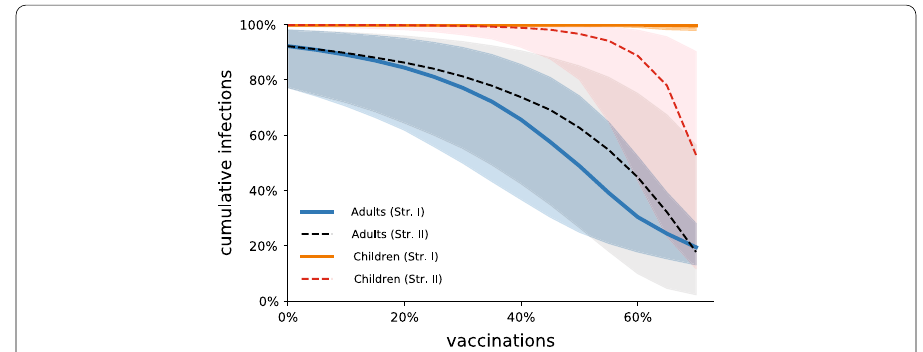
Fig. 11 Scenario of the Delta variant. We show the Monte Carlo estimation (over 100 independent simulations) of the cumulative fraction of infections among non-vaccinated adults (blue) and children (orange) at the end of the pandemic outbreak, as a function of the fraction of vaccinated population V . The solid curves refer to Vaccination strategy I, in which only adults are eligible for vaccination; the dashed curve refers to Vaccination strategy II, in which vaccine shots are randomly assigned to the entire population. The vertical bands represent the confidence interval with respect to the increased infectiousness of the Delta variant (parameters reported in the “Appendix”). The other parameters used in the simulations are listed in Table 2, q a = 0.25 , and q c =